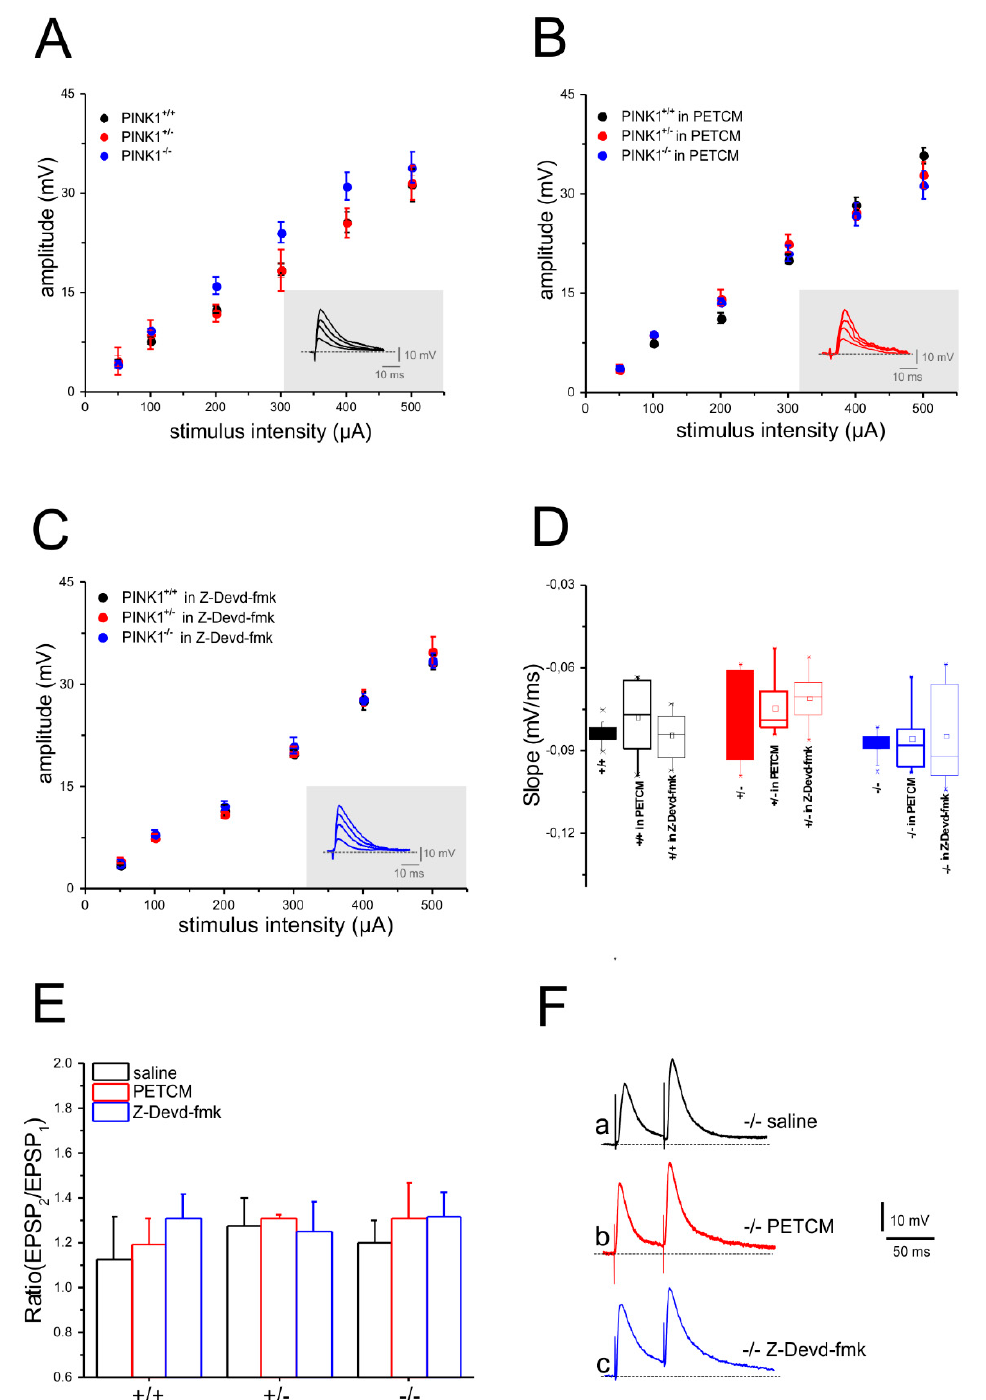
Figure 2. Pretreatment with caspase-3 inhibitor and activator does not a ff ect evoked synaptic responses in PINK1 MSNs. Stimulation of corticostriatal fibers in the presence of Picrotoxin (PTX, 50 µ M) produced glutamatergic excitatory postsynaptic potentials (EPSPs). Input–output (I / O) curves were built by measuring the amplitude of EPSPs evoked by increasing intensities of stimulation. ( A ) The I / O relationships were not significantly di ff erent between the three PINK1 genotypes. The inset shows representative superimposed traces of a single recording. ( B ) Treatment with PETCM (30 µ M) did not induce significant di ff erences neither among the three genotypes nor as compared with non-treated MSNs. ( C ) Similarly, treatment with Z-Devd-fmk (5 µ M) did not a ff ect the I / O curves in any experimental condition. ( D ) Plots showing EPSP slope values recorded from PINK1 +/+ (black), PINK1 +/